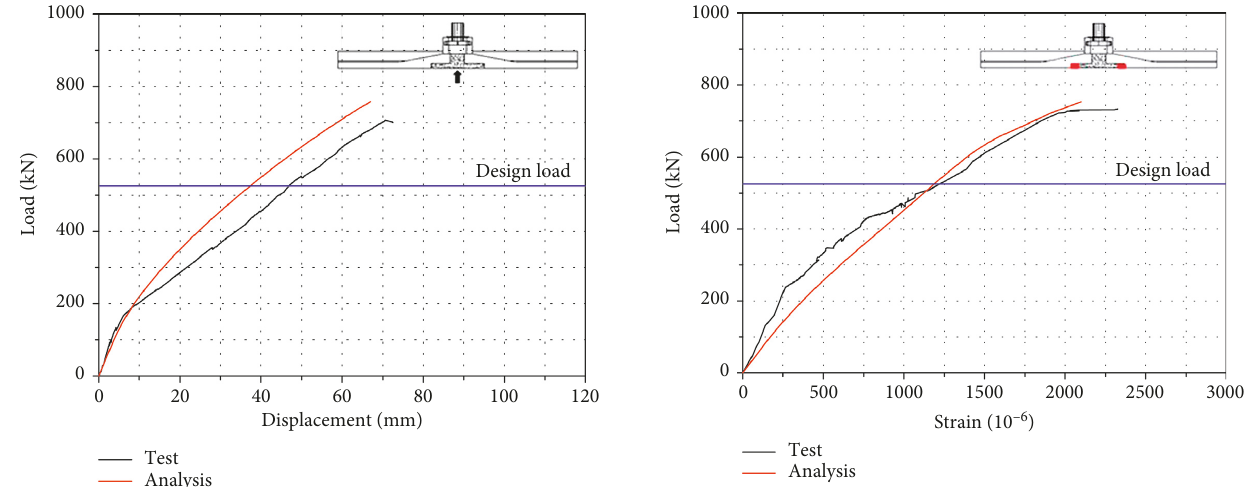
Figure 6: Load-displacement relationship at center. Figure 7: Load-strain relationship of the reinforcing bars at